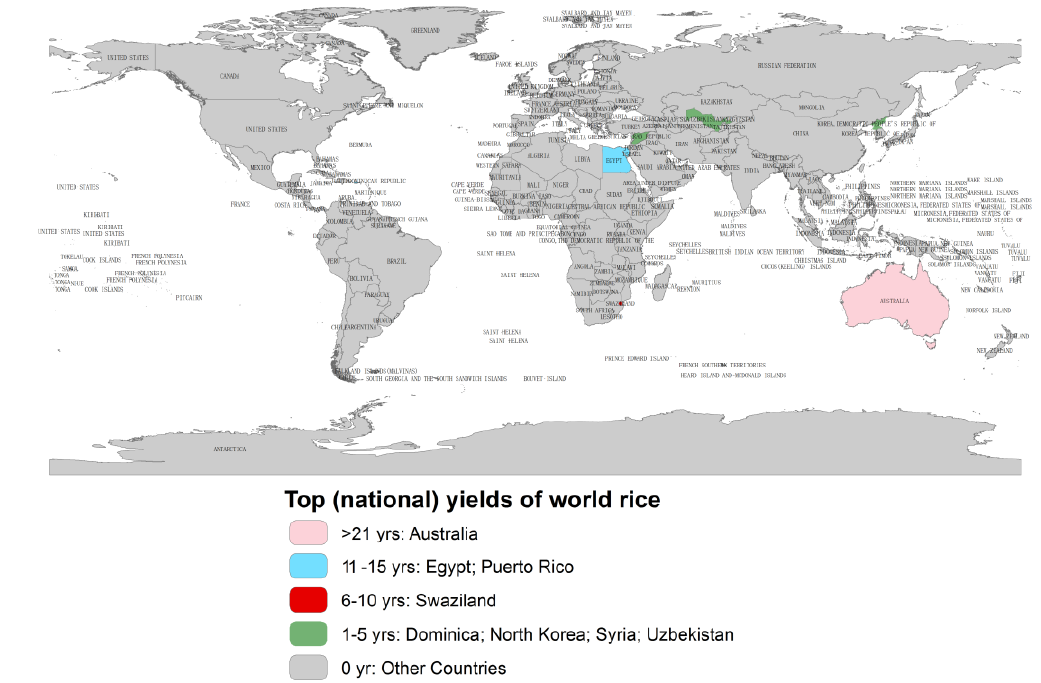
Figure 3. Distribution of top (national) yields of world rice from 1961 to 2020. 3.5. Variation Trends for Average and Top Yields of World Rice from 1961 to 2020 up to 2030 The variation trends for average and top yields of world rice from 1961 to 2020 and up to 2030 are shown in Figure 4.